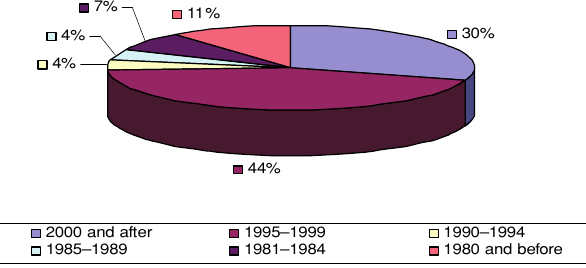
Figure 9: Times of establishment of sour cherry orchards in Northern Hungary